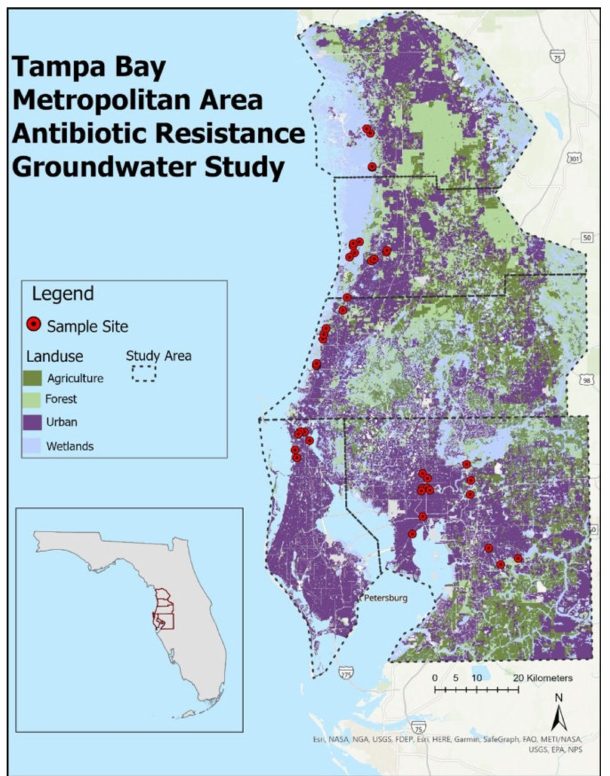
Figure 2. The sample sites and landuse for the Tampa Bay Metropolitan Area, FL antibiotic resistance groundwater study